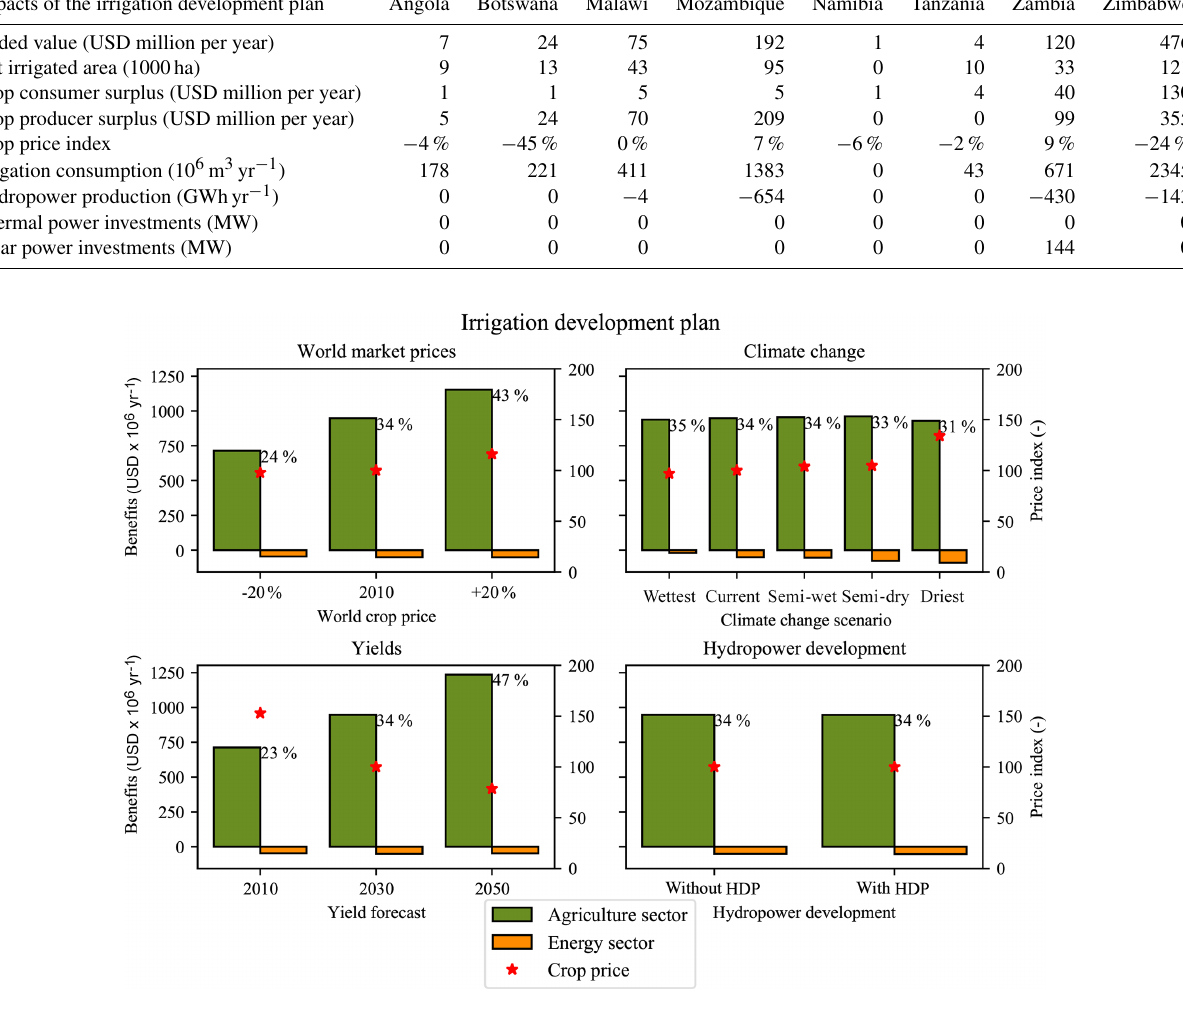
Figure 11. Sensitivity of the irrigation development plan to uncertainties in future climate and socio-economic development. Benefits are calculated from with/without analyses of the irrigation development in variations of the 2030 scenario, and the percentages show the internal rate of return. The value of the irrigation development plan is found to be very sensitive to crop yields, world market crop prices, and less sensitive to the climate change scenario. The crop price index is proportional to the weighted average crop price of supplied crops within the Zambezi, and 100 is the reference value for the 2030